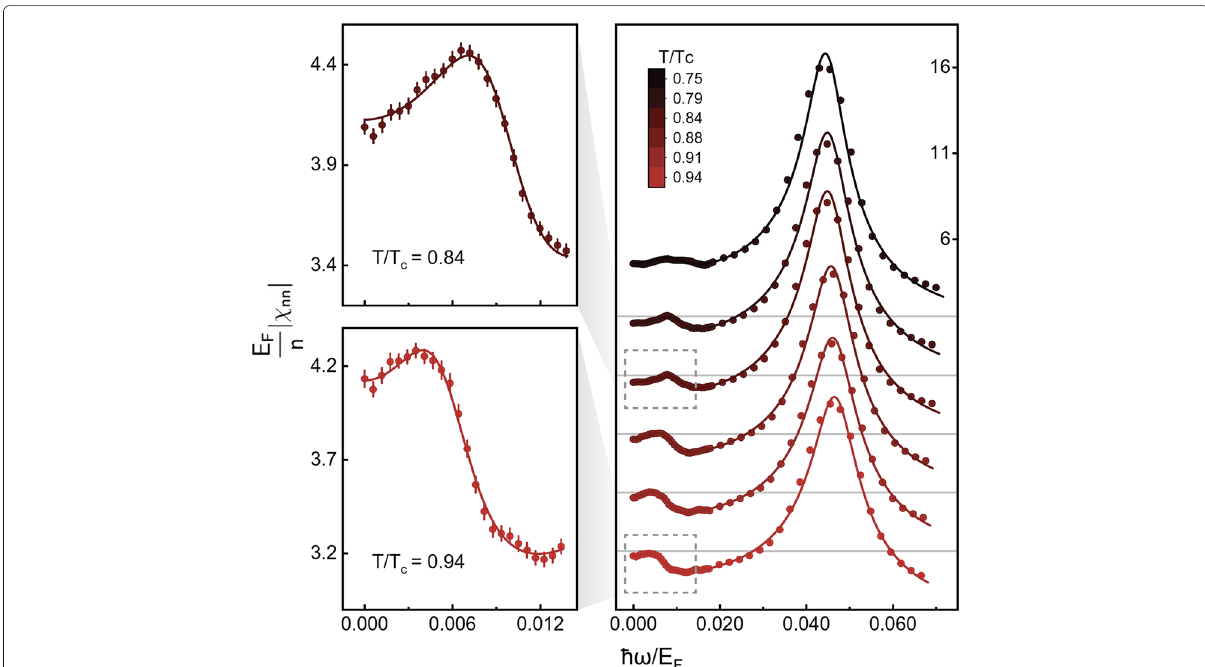
Fig.14 The spectra from 0.75 T c to 0.94 T c (top to bottom) are shown on the right panel. The two small subplots on the left give a zoomed view of the low-lying second-sound response at 0.84 T c and 0.94 T c , respectively. The solid lines are the fitting curves, in the form of Eq. (29). Adaptedfrom Ref. [33]